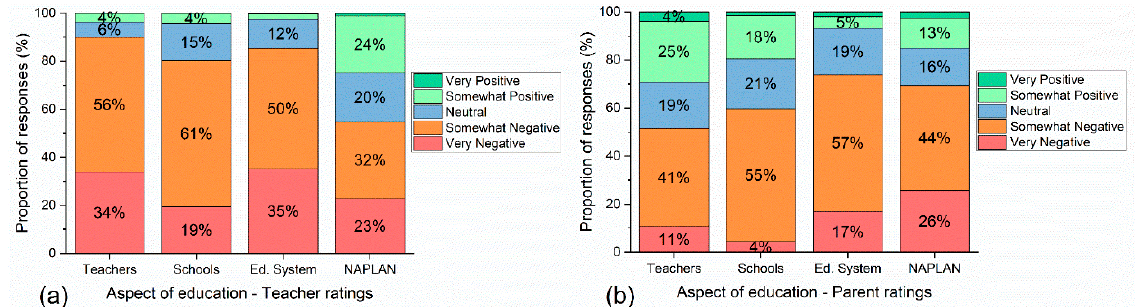
Figure 2. The perception of the positive/negative tone of media reports across different aspects of education for ( a ) teachers, and ( b ) parents. Please note that the labels for percentages lower than 3% are omitted from the charts.